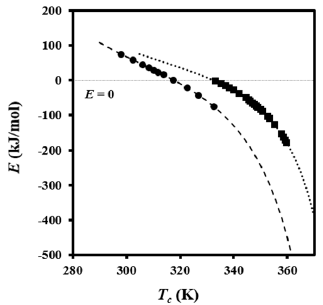
Figure 8. Dependence of effective activation energy on crystallization temperature for regimes II ( ■ ) and III (•). Extrapolated data for regimes II and III are indicated by dotted and dashed lines, respectively.